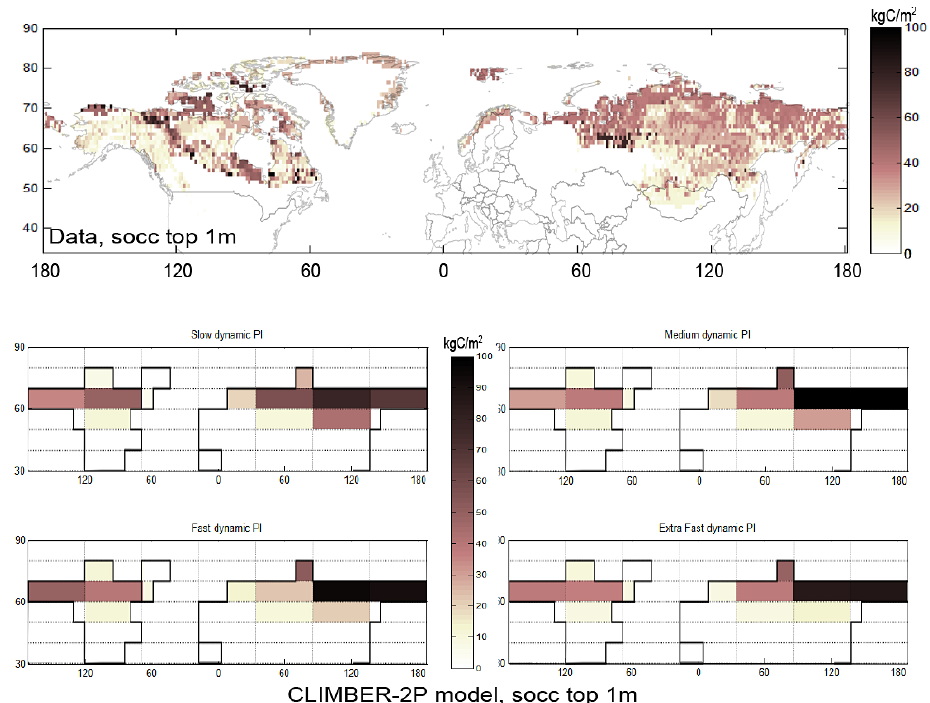
Figure 17. SOCC data (kgCm − 2 ) for the top 100cm of soils, Hugelius et al. (2013) (top panels). Modelled PI(tr) SOCC (kgCm − 2 ) in permafrost soils for top 100cm (lower panels).